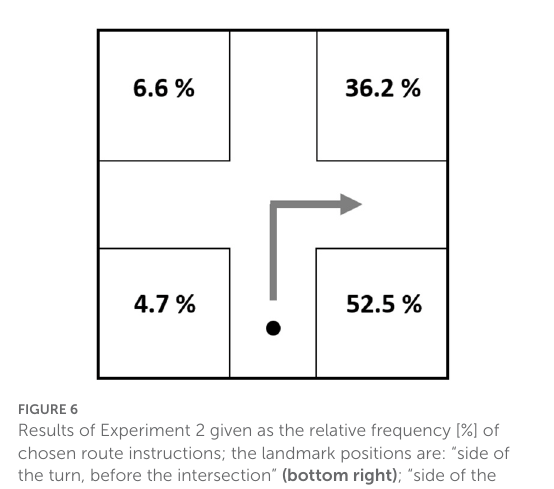
FIGURE6 Results of Experiment 2 given as the relative frequency [%] of chosen route instructions; the landmark positions are: “side of the turn, before the intersection” (bottom right) ; “side of the turn, behind the intersection” (top right) ; “opposite side of the turn, behind the intersection” (top left) ; “opposite side of the turn, before the intersection” (bottom left)